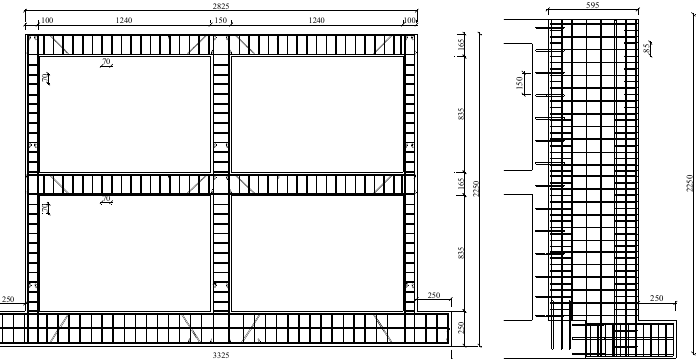
Fig. 1. Dimensions and reinforcement layouts of RC frame and external shear wall for the 1st group tests (Arslan, 2007; Kaltakci, 2007)